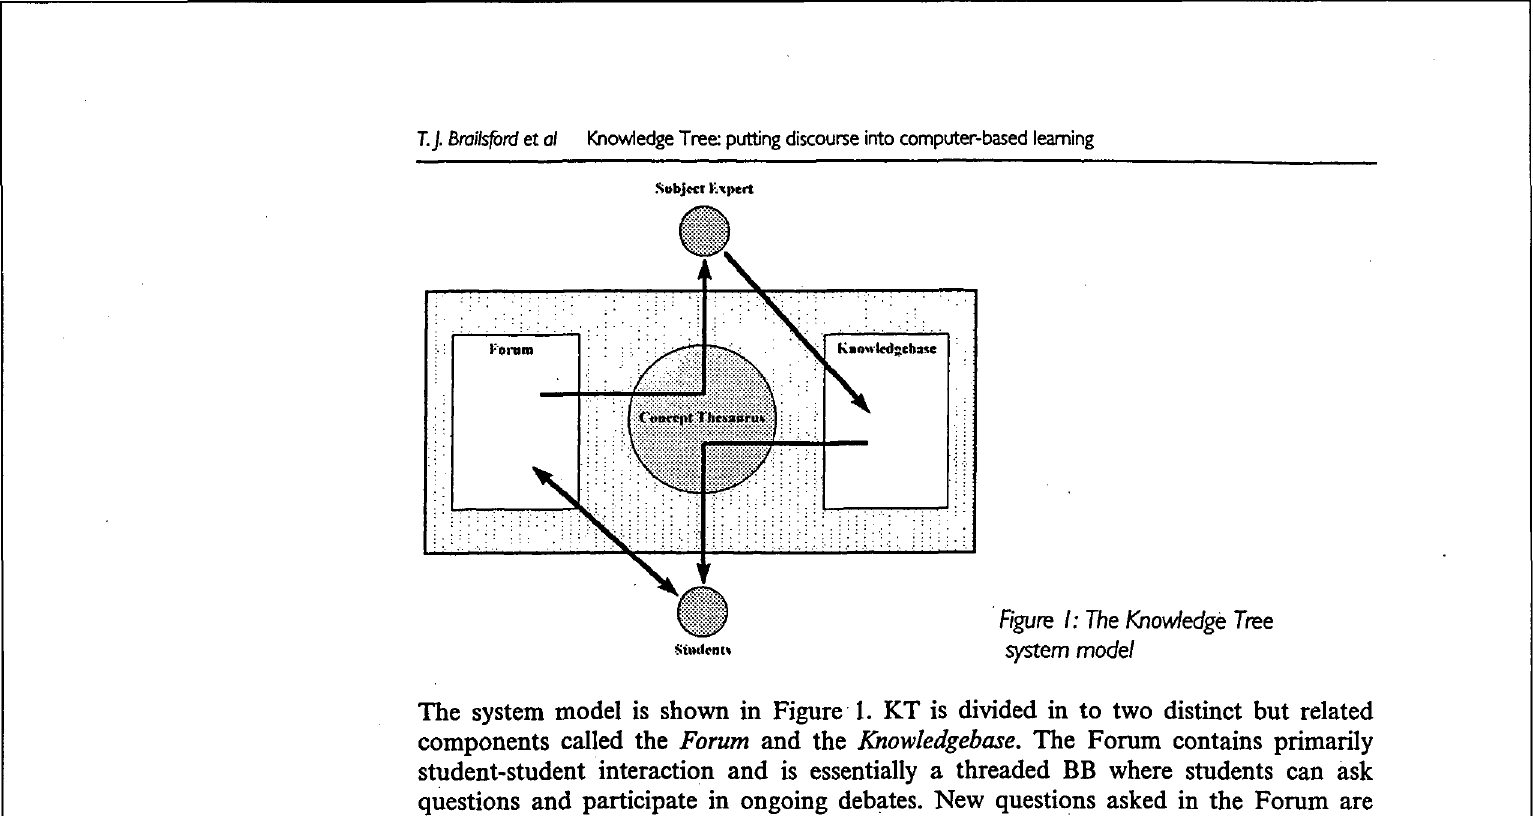
figure /: The Knowledge Tree system model